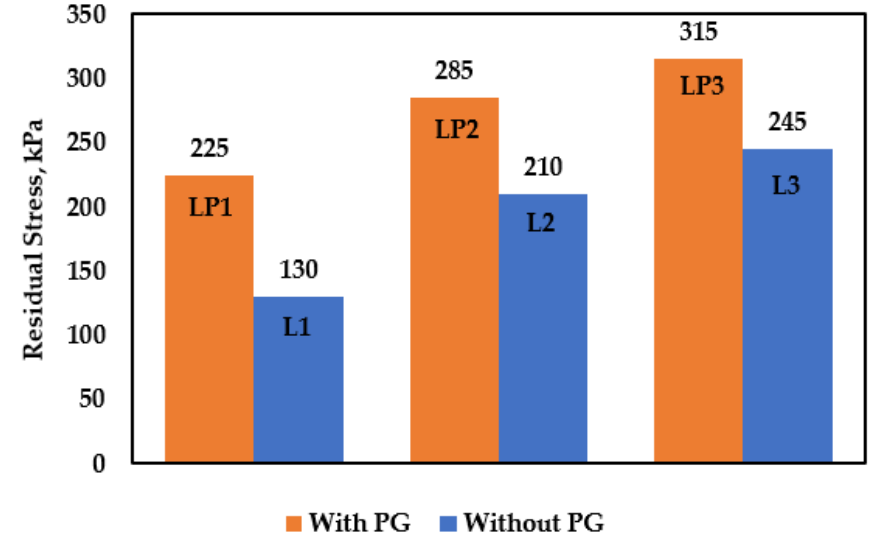
Figure 3. Influence of PG on the residual strength of lime-stabilized soil.